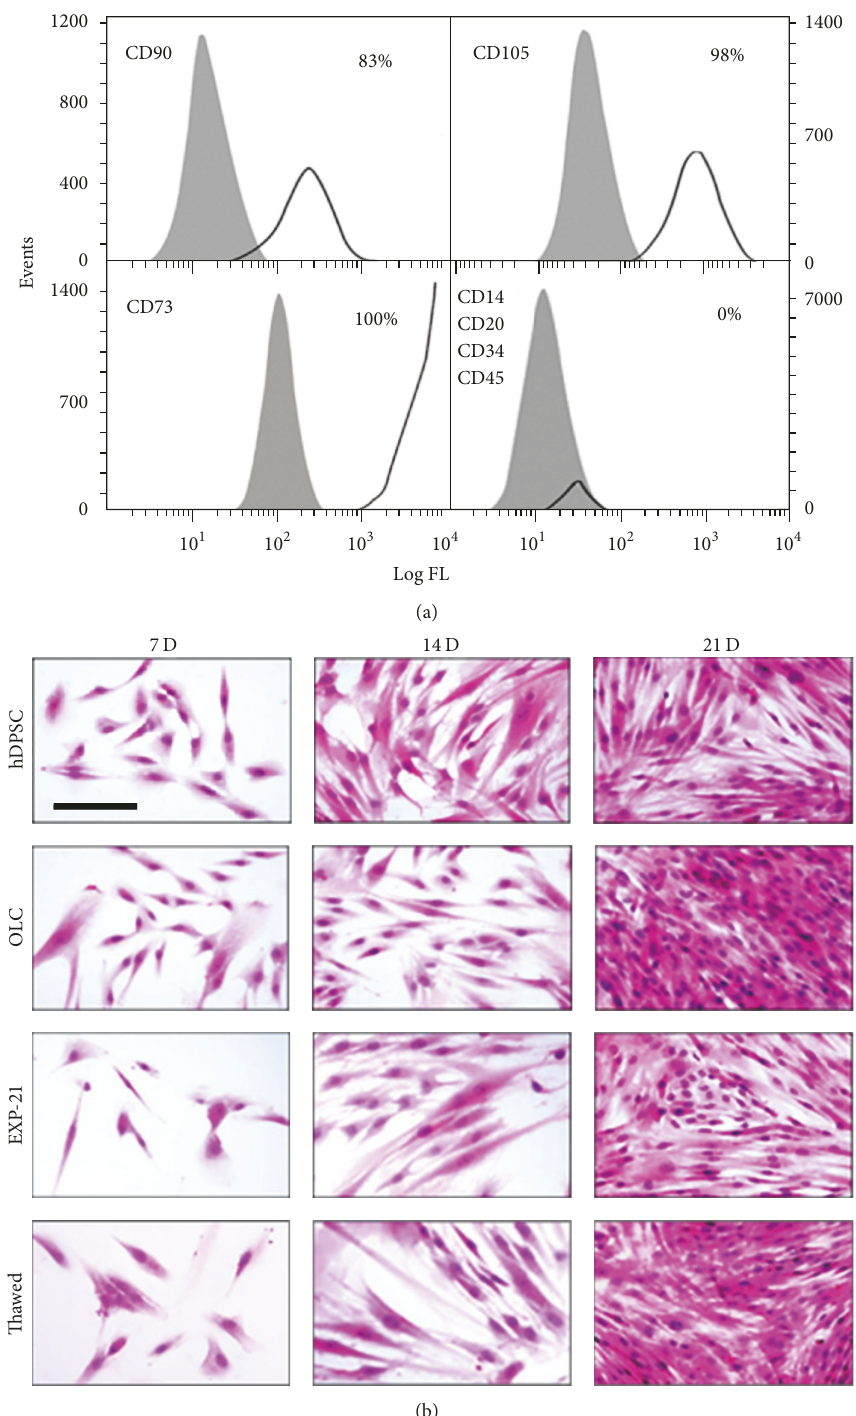
Figure 1: hDPSC surface markers and morphology of the cultures . The hDPSC were isolated from dental pulp of permanent teeth from three healthy donors. (a) The analysis by flow cytometry showed a homogeneous cell population positive for mesenchymal markers CD90, CD105, and CD73 and negative for early hematopoietic markers CD34, CD45, CD14, and CD20. Cells from fourth passage were recorded of each sample in triplicate. Data correspond to a representative experiment. (b) The hDPSC showed spindle-shape or fibroblast-like morphology with adherence to the surface and colony formation ability growing in a swirling-like pattern. During the differentiation process (OLC) and in the EXP-21, the cells maintained a typical fibroblastic-like shape with long cytoplasmic processes and were orderly arranged with a tendency to align themselves in parallel lines. The EXP-21 cells after cryopreservation, storage, and thawing showed similar morphology than their regular noncryopreserved cells. Scale bar: 200 𝜇